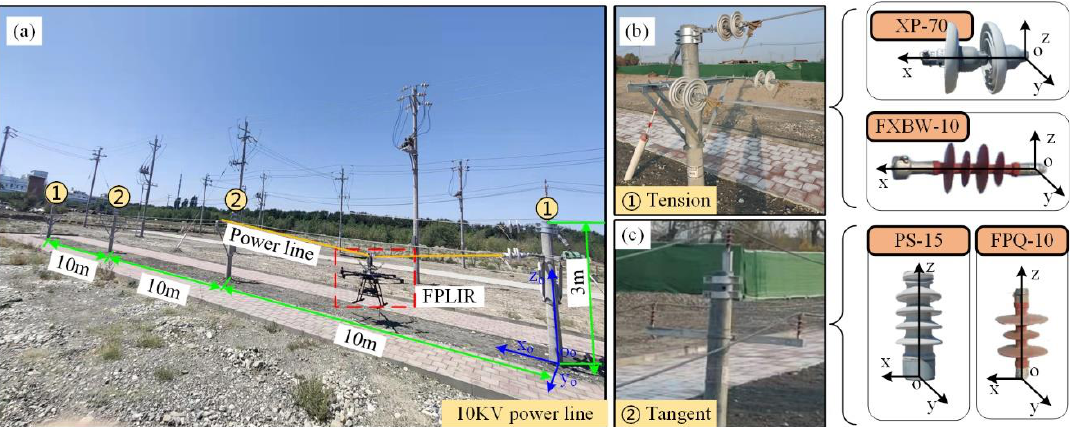
Figure 16. Inference results. ( a ) Standard YOLOv5; ( b ) depth-attention YOLOv5.